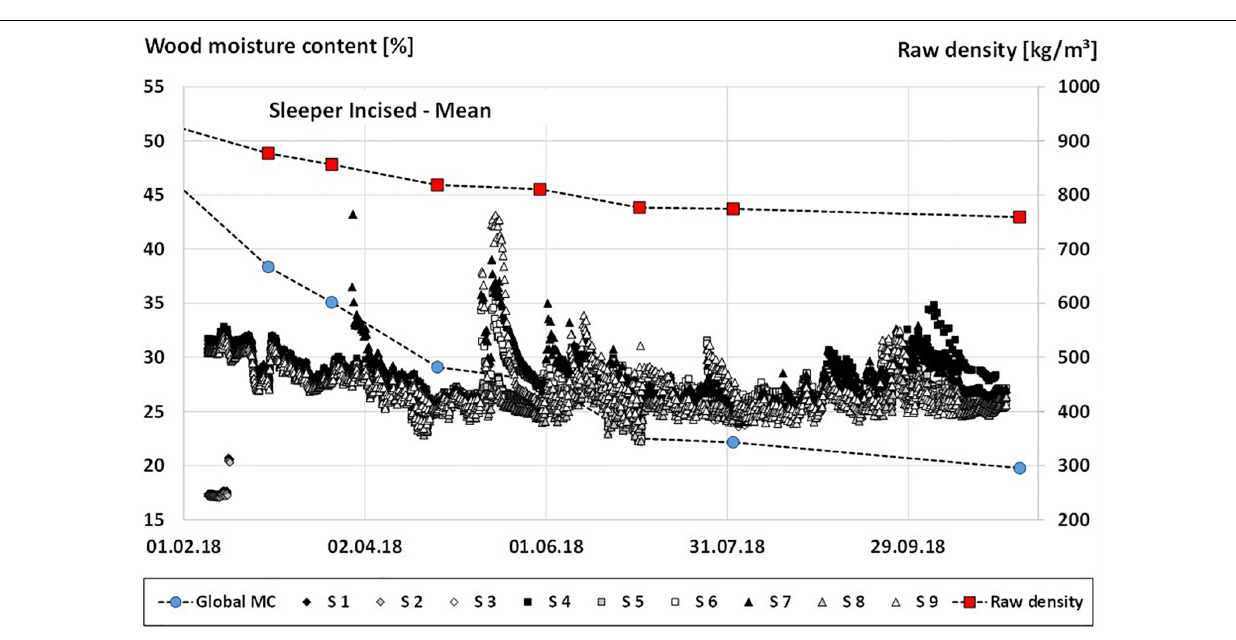
Frontiers in Forests and Global Change |